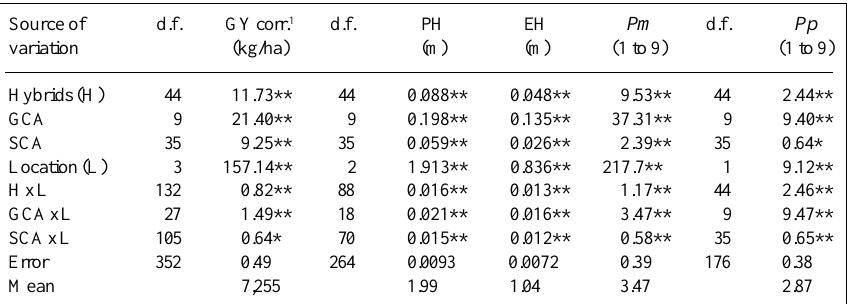
Table IV - Mean squares of the analysis of variance of plant height (PH), ear height (EH), grain yield corr. (GY corr.), and severity scores for Phaeosphaeria maydis ( Pm ) and Puccinia polysora (Pp ) in 45 maize single-cross